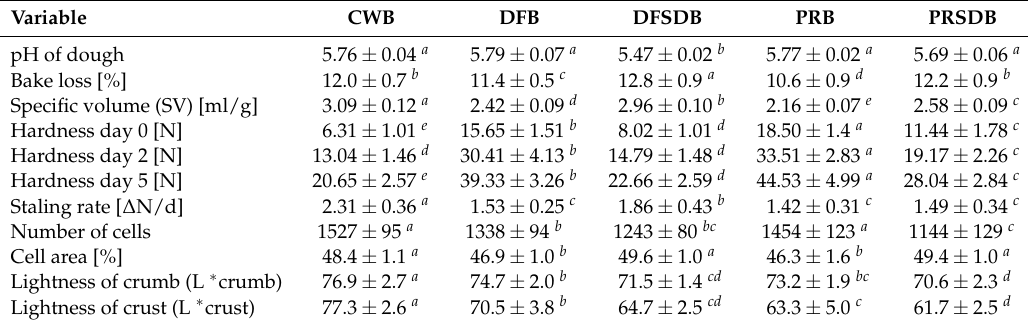
Table 6. Bread quality characteristics of control wheat bread and faba bean bread